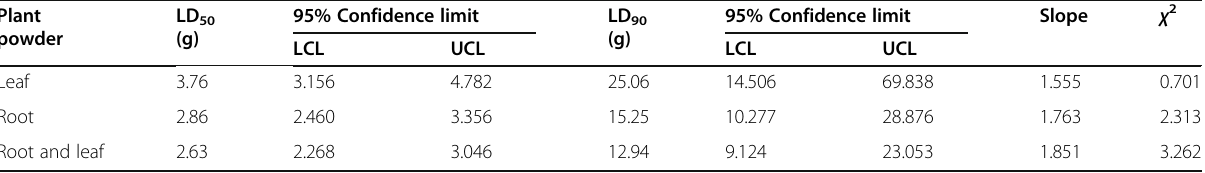
Table 4 Lethal dosage effect of Petiveria alliacea powder after 2 h post-treatment period Plant LD 50 powder